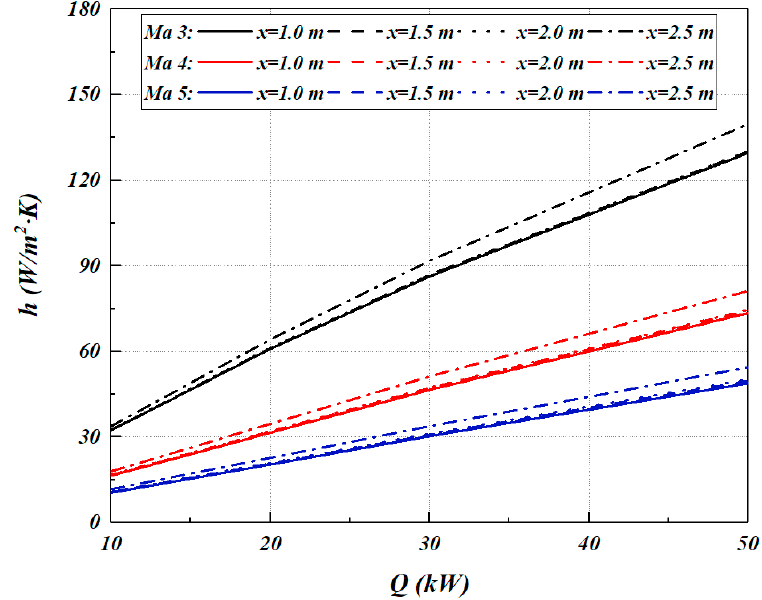
Figure 14. Variation trend of convective heat transfer coefficient ( h ) with heat dissipation capacity ( Q ) along x direction at the low-temperature region.